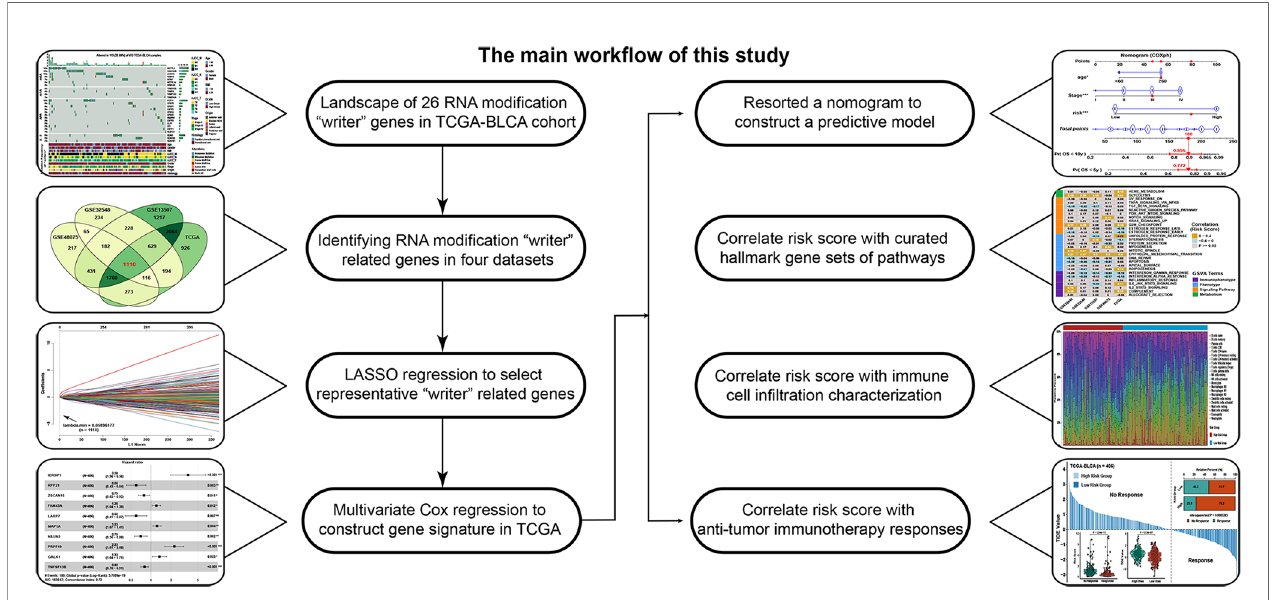
FIGURE 7 | Flow chart of this